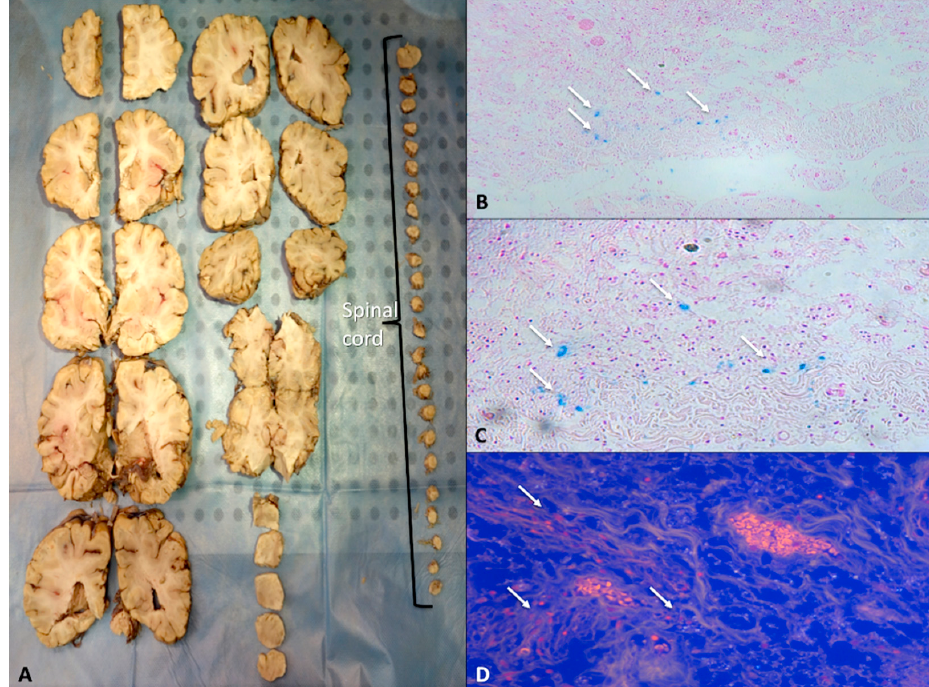
Figure 4. ( A ) After accurate sections, spinal cord roots and vertebral levels can be counted. ( B ) Subacute traumatic injury of the spinal cord: clearly visible, in B and C, ferrous particles deriving traumatic injury of the spinal cord: clearly visible, in B and C , ferrous particles deriving from hemoglobin from hemoglobin colored by the method of Perls (arrows) (B ×60; C ×100). ( D ) In fluorescence, small colored by the method of Perls (arrows) ( B × 60; C × 100). ( D ) In fluorescence, small hemorrhagic hemorrhagic collections in subjects with acute cervical medullary injury (arrows) (×200). collections in subjects with acute cervical medullary injury (arrows) ( × In presence of spinal cord lesions, pathologists should attempt to locate the radicular-segmental